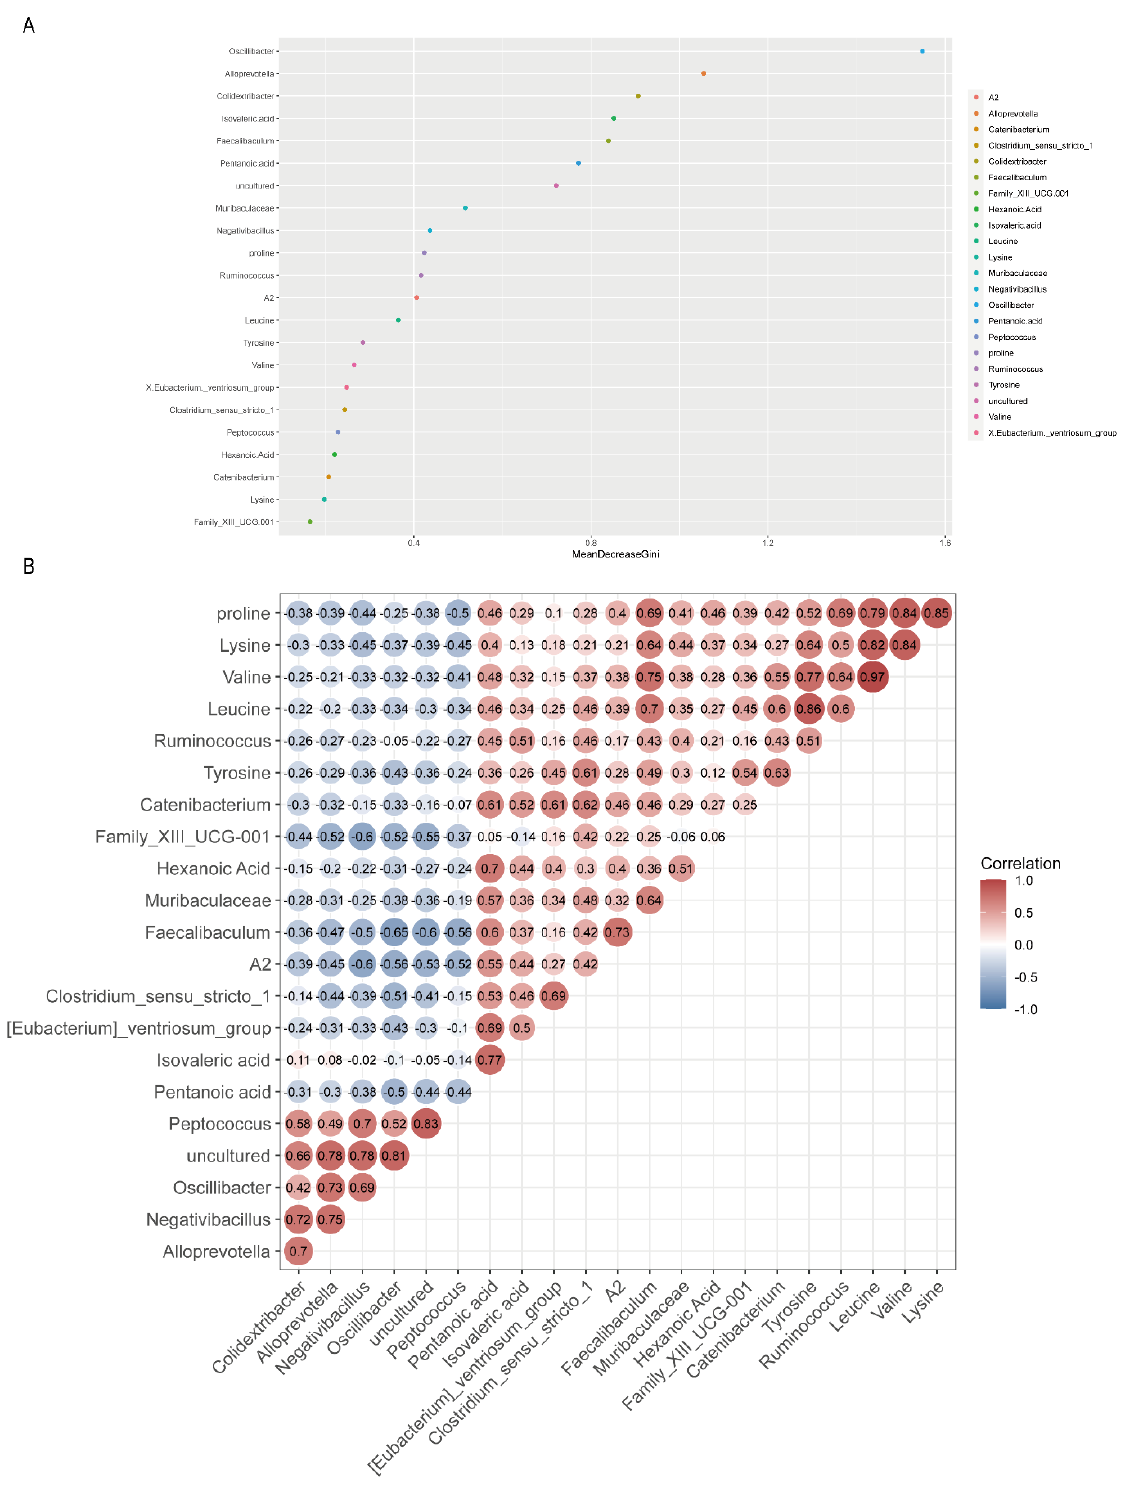
Figure 5. The relationship between different microbiota and SCFA and neurotransmitters. ( A ) Random Forest ranking of the differential microbiome, SCFAs, and amino acids; ( B ) Heat map of correlation between the differential microbiome, SCFAs, and amino acids. Related methods for generating graphs using Pearson correlation calculations. The redder the color, the more positive the correlation; the bluer the color, the more negative the correlation.